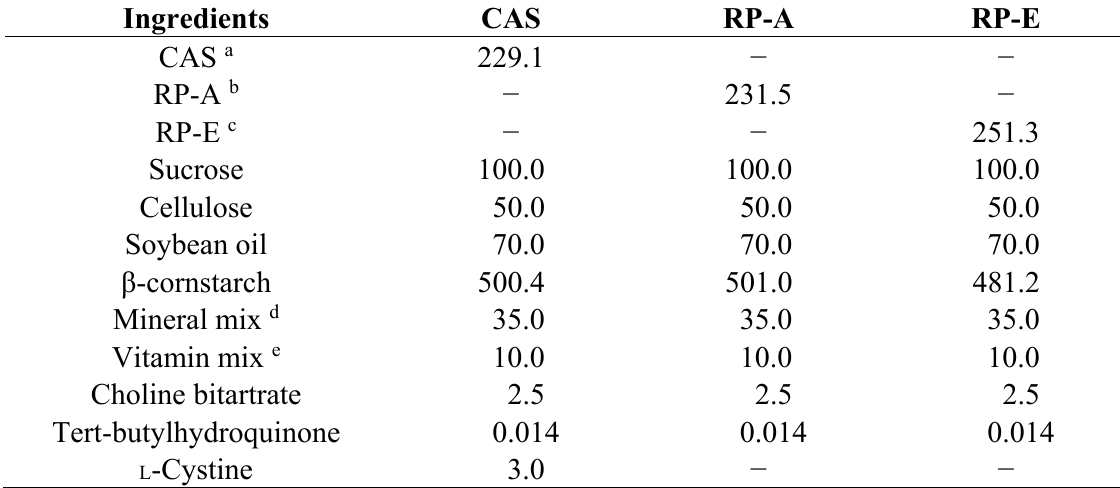
Table 1. Composition of experimental diets (g/kg